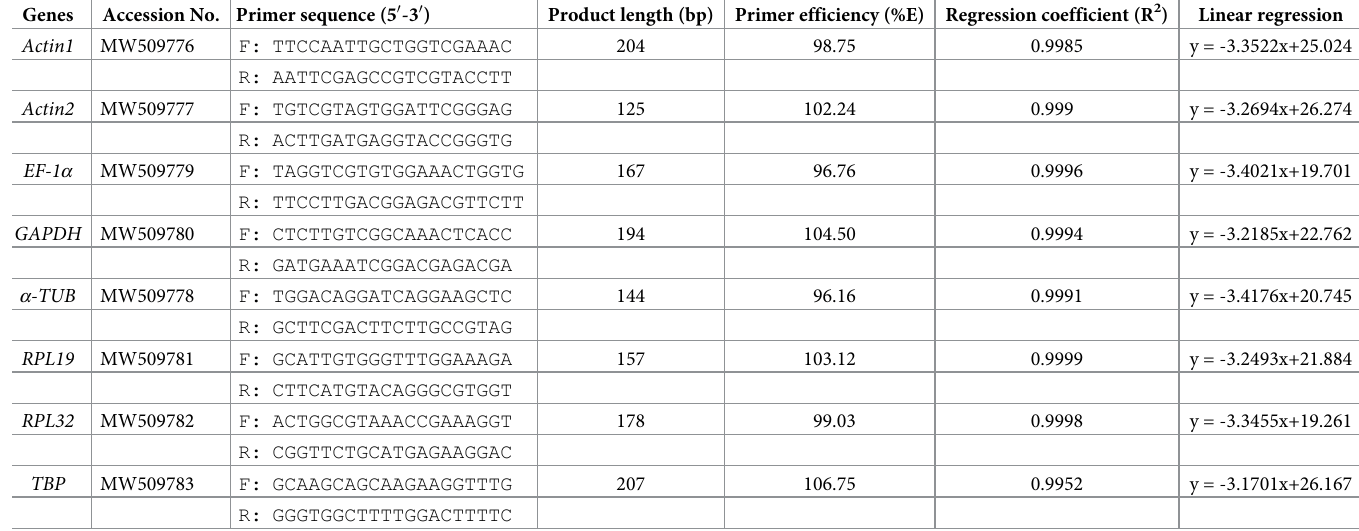
Table 1. Primers for candidate reference genes used in RT-qPCR analyses. Genes Accession No. Primer sequence (5 0 -3 0